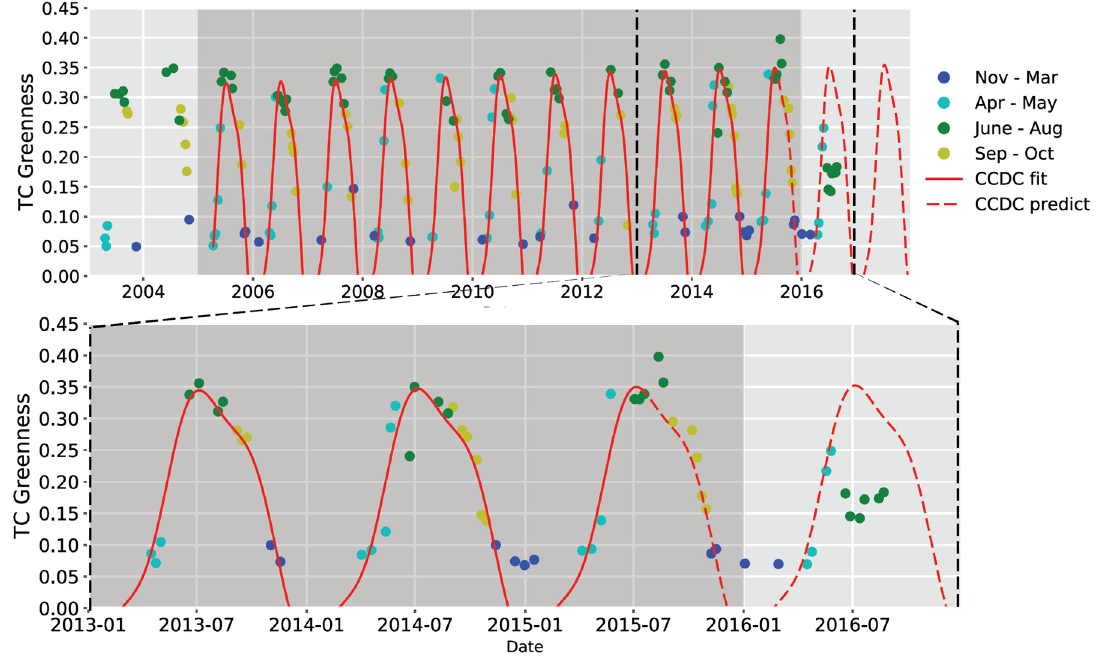
Figure 2. Example of Continuous Change Detection and Classification (CCDC) model fitting and prediction for a single pixel. The dark gray area shows the stable base period used to generate the CCDC fit model (solid line). The fitted model is used to predict Tasseled Cap Greenness (TCG) values during the monitoring period (in this case, 2016, dotted line). This pixel represents an example of defoliated forest, where observed TCG values from June through August 2016 (green points) were less than half of their modeled long-term average values.